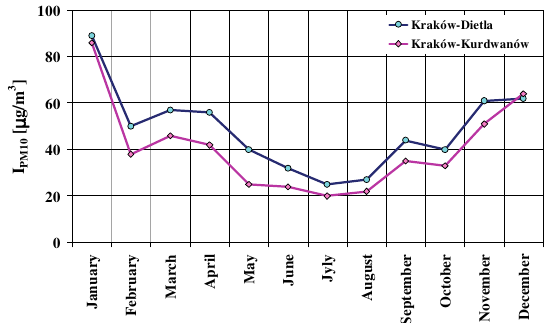
Fig. 1. The immission of particulate matter PM10 values obtained from Kraków–Dietla station and Kraków–Kurdwanów station in 2016